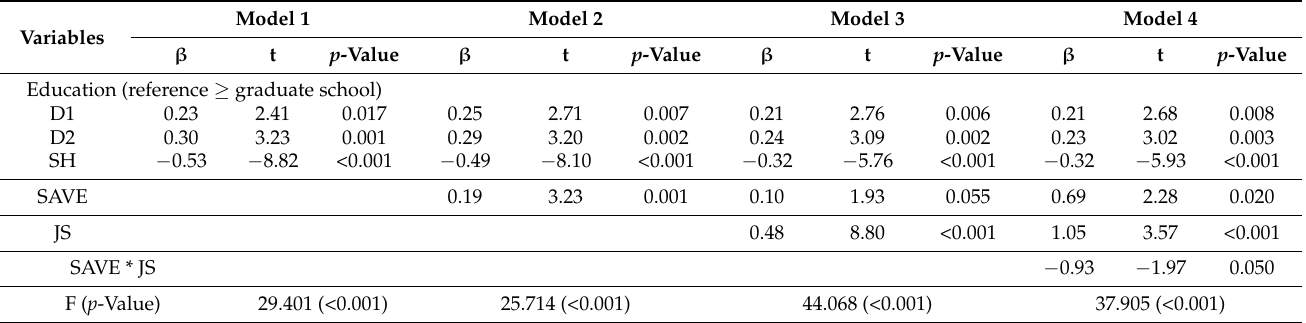
Table 5. Hierarchical regression analysis of factors affecting burnout in dental